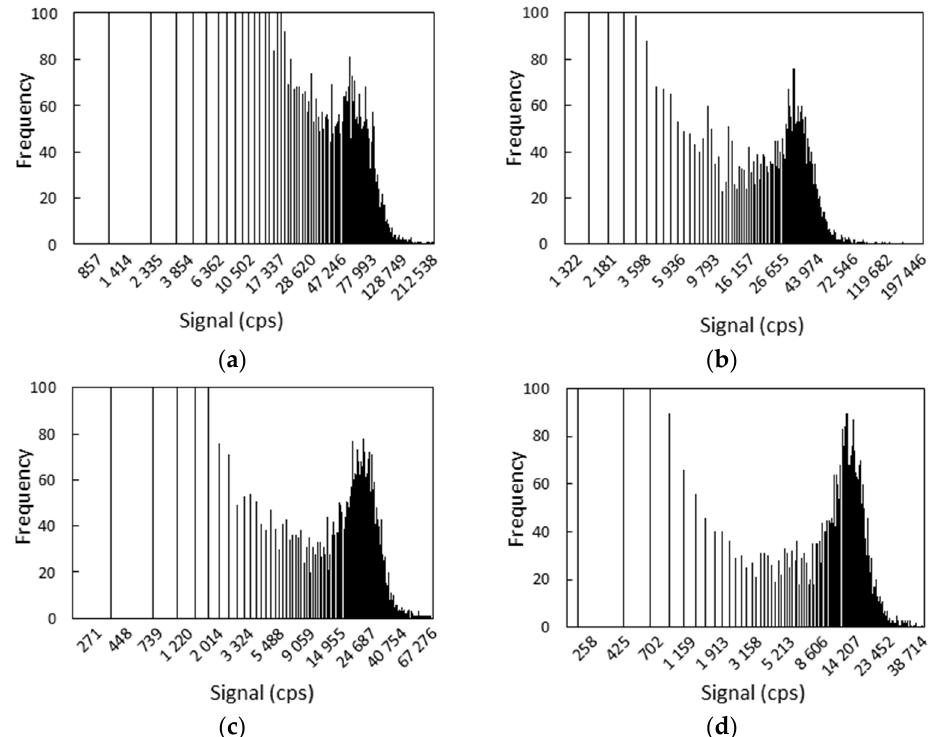
Figure 2. Histograms of signals obtained for a NIST RM8012 suspension with the following dwell time, analysis time, and gold concentrations: ( a ) 1 ms, 1 min, and 23.2 ng/kg; ( b ) 2 ms, 2 min, and 9.8 ng/kg; ( c ) 3 ms, 3 min, and 8.0 ng/kg; ( d ) 5 ms, 5 min, and 4.9 ng/kg. Note that the x axis has nonlinear scale to better display the limit between background and particles.